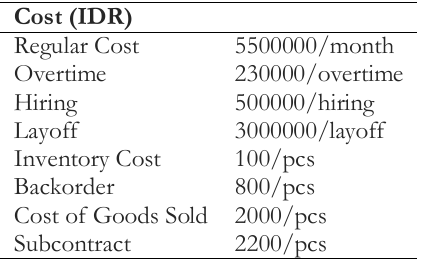
Table 4. Cost structure.